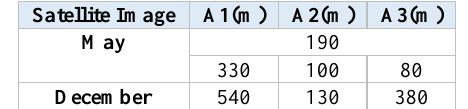
Figure 8. Location of low NDVI values in December